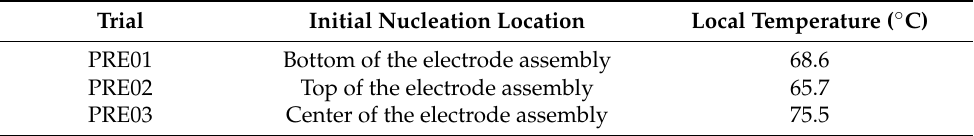
Figure 7. Thermograms obtained during free cooling without an electrical field. ( a ) Without electrode assembly (TC2) and ( b ) with electrode assembly (TC1 and TC2). Table 5. Preliminary tests without applying a current.